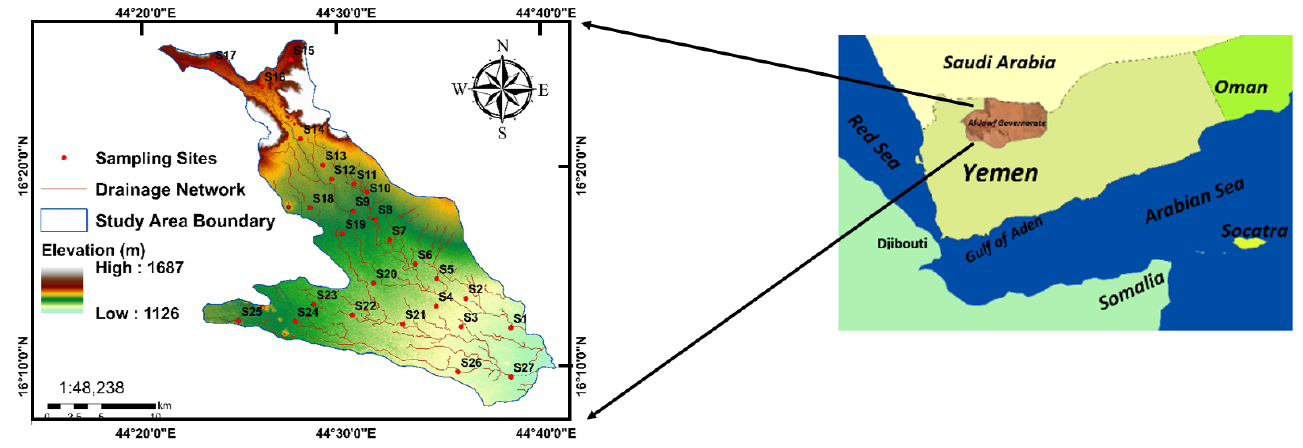
Figure 1. Location map and sampling sites of the research study area.